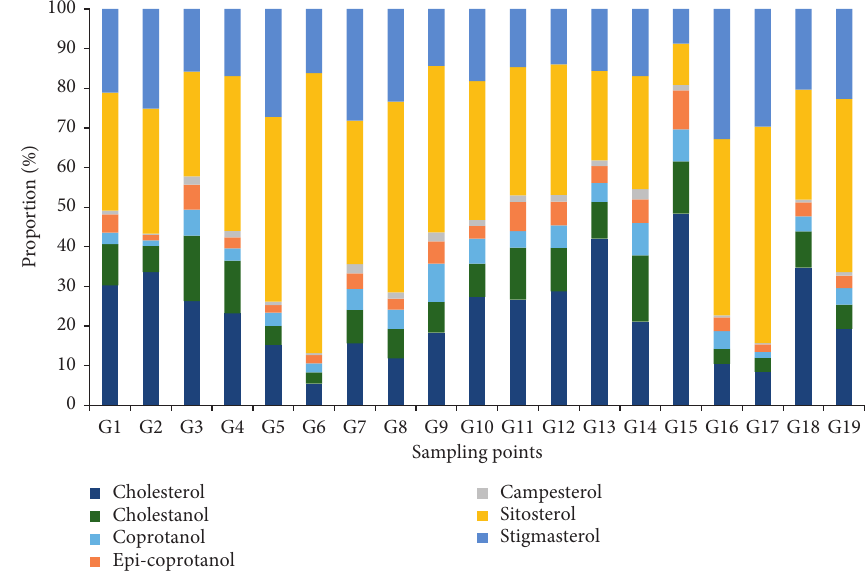
Figure 2: Proportions of seven sterols in total sterols in sediments of the Guanting